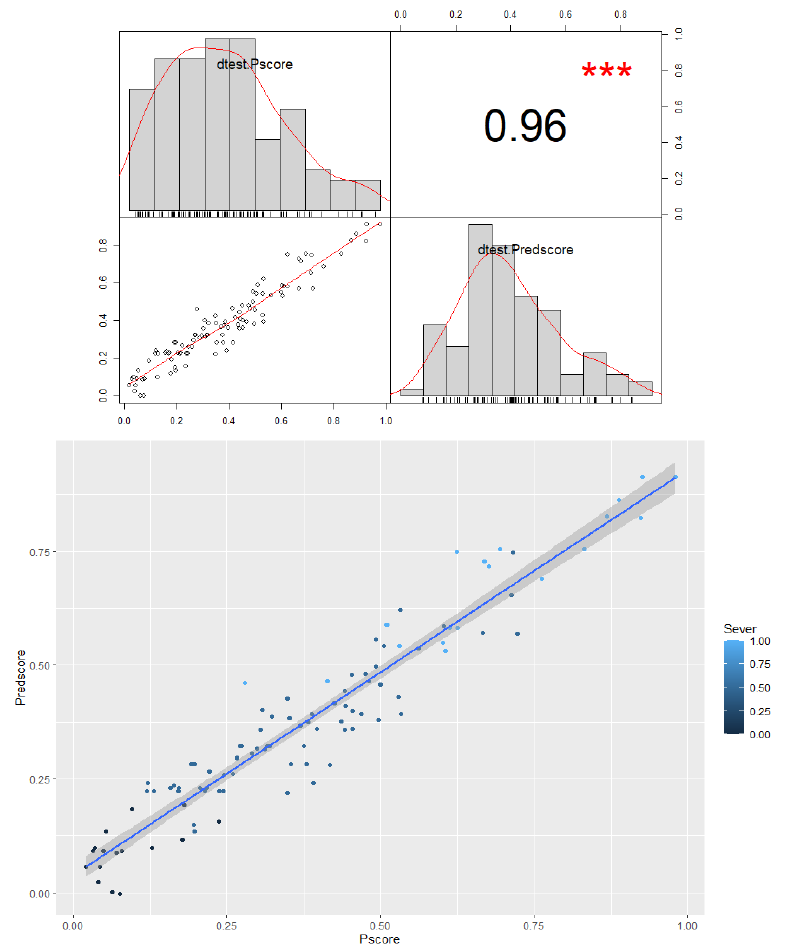
Figure 3. Pearson’s correlation coefficient evidences a strong linear relationship of the test data between the Pscore (priority given by physicians to patients using 20 variables) and Predscore ( ¯ ps associated with the final fitted model ( 3 ). *** There is a robust linear relationship between the predicted score from the test data and the initial score, Pscore